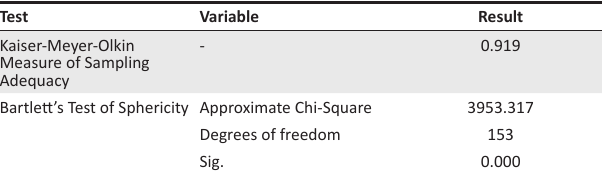
TABLE 1: KMO and Bartlett’s